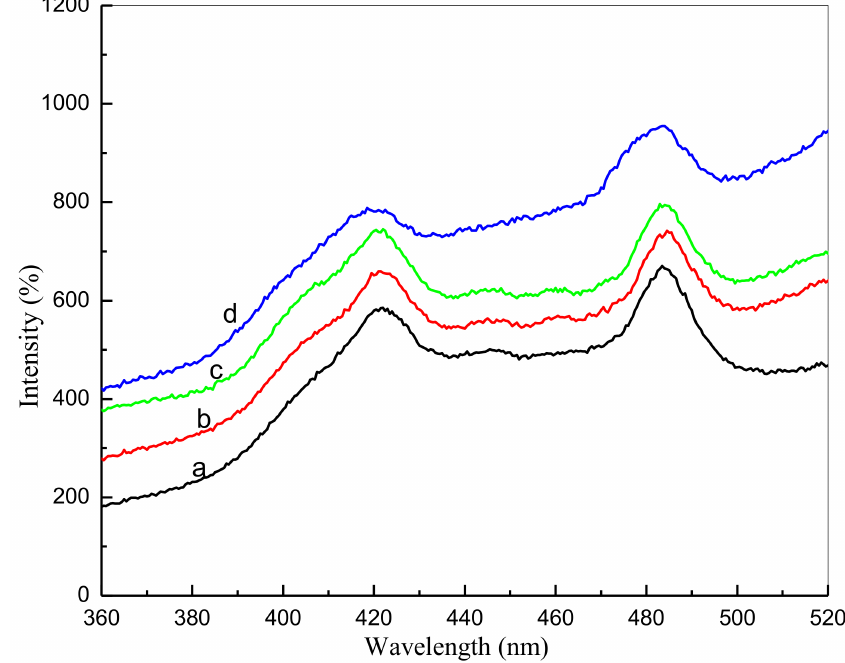
Figure 9. Nanoparticle photoluminescence at calcination temperatures of 500 ◦ C ( a ), 600 ◦ C ( b ), 700 ◦ C ( c ), and 800 ◦ C ( d